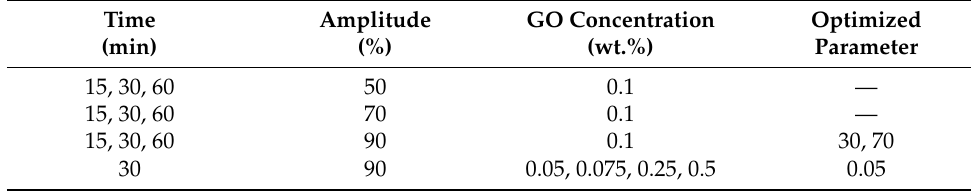
Figure 2. Water cooling setup of nanocomposite preparation using a sonicator. Table 1. Summary of ultrasonic parameters employed. Table 1. Summary of ultrasonic parameters employed.